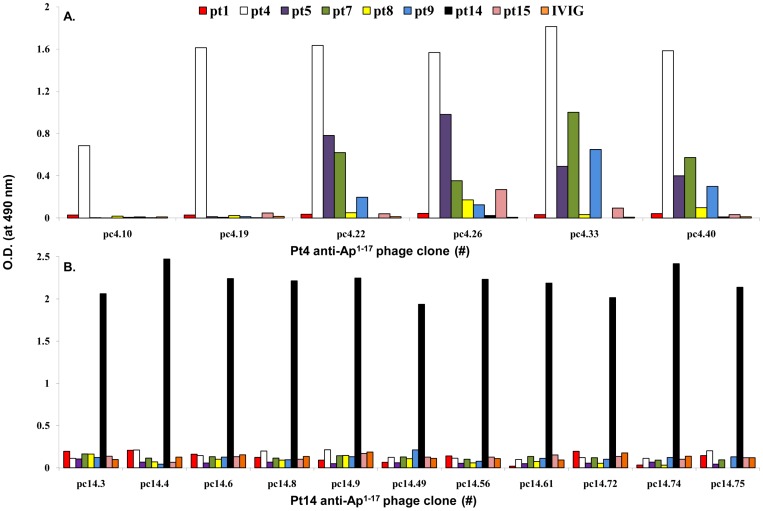
Anti-Ap1-17 Abs from different SSc patients recognize different motifs within the same peptide.Microtiter plates were coated with 10 µg/ml anti-Ap1-17 Abs from 8 SSc patients or with IVIG as negative control. Supernatants from pt4 (Panel A) and pt14 (Panel B) phage clones were diluted 16-fold in PBS and added to the wells (100 µl/well). After a 4-h incubation, the Ab-phage clone interaction was detected with HRP-conjugated anti-M13 mAb and o-phenylenediamine. Each data point is the mean of duplicate wells. The data are representative of two experiments.